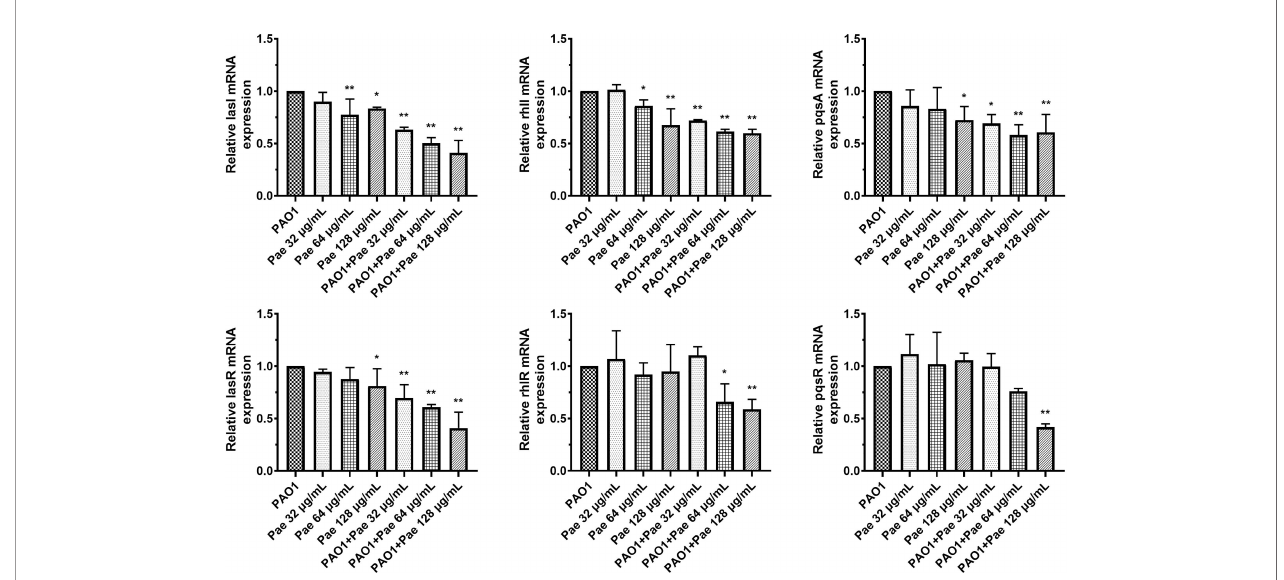
FIGURE 3 | Transcriptional levels of the QS genes during P. aeruginosa infected macrophages (MOI = 100:1) following pretreatment and treatment with paeonol. lasI, rhlI, pqsA, lasR, rhlR, and pqsR. “ Pae 32 m g/mL ” , “ Pae 64 m g/mL ” , “ Pae 128 m g/mL ” indicate that RAW264.7 cells were pretreated with paeonol for 3 h before infection with PAO1. “ PAO1+Pae 32 m g/mL ” , “ PAO1+Pae 64 m g/mL ” , “ PAO1+Pae 128 m g/mL ” indicate that RAW264.7 cells were infected with PAO1 and treated with paeonol at the same time. The expression of mRNA was tested by RT-PCR. All data were expressed as means ± SD (n=3). * P < 0.05 or ** P < 0.01 vs the control